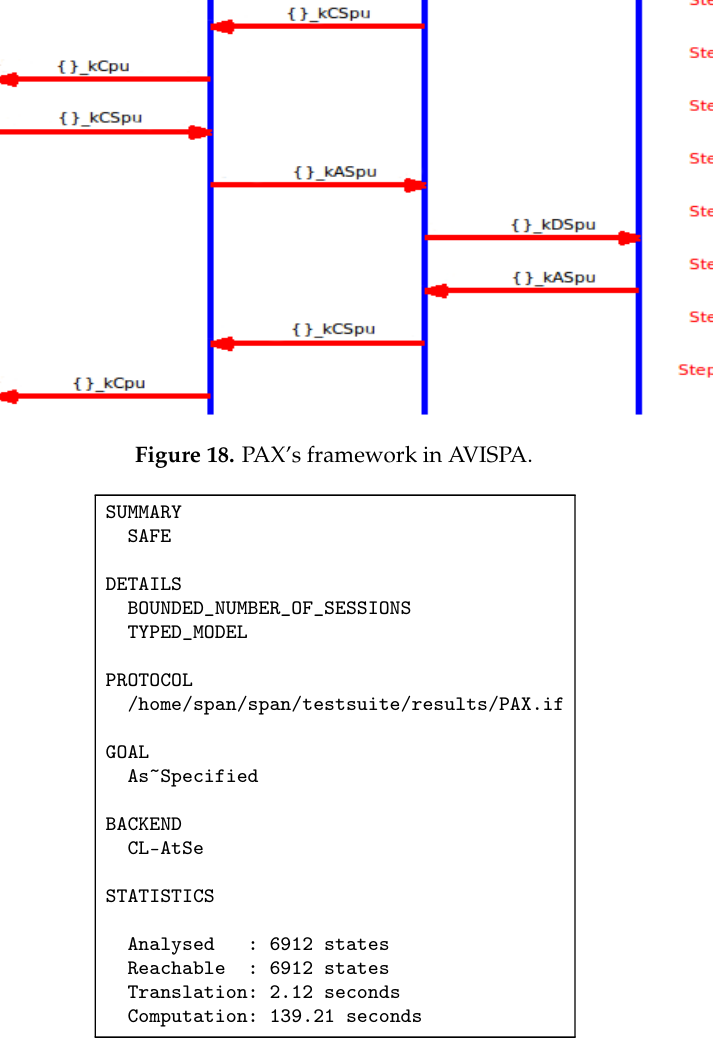
AVISPA. Figure 19. PAX’s result in CL-AtSe. Figure 19. PAX’s result in Figure 18. PAX’s framework in